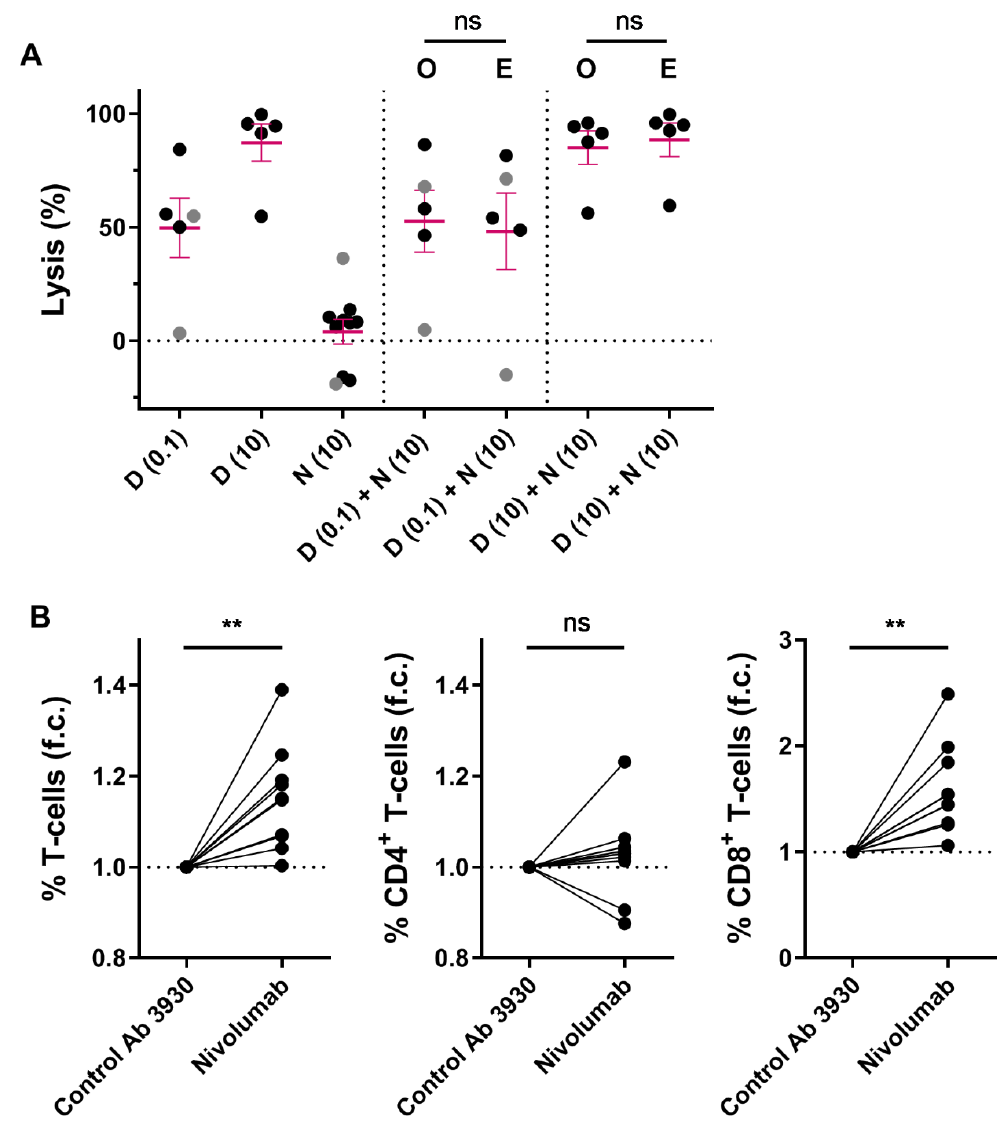
Figure 3. Short-term ex vivo co-treatment with nivolumab does not enhance daratumumab-mediated MM cell lysis. ( A ) BM-MNCs derived from 2 NDMM (grey) and 8 daratumumab-naïve RRMM (black) patients were treated with daratumumab (0.1 µ g / mL ( n = 5) or 10 µ g / mL ( n = 5)), nivolumab 10 µ g / mL, or the combination of both antibodies for 48 h, after which MM cell specific lysis was determined by using flow cytometry. Dots represent an individual data point, and error bars represent the mean ± SEM; experiments were performed in duplicate. The observed MM cell lysis in samples treated with both daratumumab and nivolumab was compared with the expected lysis, which was calculated using the Bliss method as described in the Materials and Methods. The p -values between observed and expected lysis were calculated by using paired Student’s t -tests. ( B ) The fold changes in the CD3 + , CD4 + , and CD8 + T-cell frequencies were calculated by dividing the % T-cells (of live BM-MNCs) in wells treated with nivolumab (10 µ g / mL) by the % T-cells in wells treated with CNTO 3930 control antibody (10 µ g / mL) ( n = 10). Paired Student’s t -tests were used to calculate significance. Abbreviations: D, daratumumab; N, nivolumab; SEM, standard error of mean; O, observed lysis; E, expected lysis; ns, not significant; ** p ≤ 0.01, f.c., fold change. We also assessed the effect of nivolumab on daratumumab-mediated MM cell lysis in an assay with longer incubation time (96 h), by using healthy donor-derived peripheral blood mononuclear cells (PB-MNCs) and MM cell lines. To this end, PB-MNCs were first pre-incubated with or without